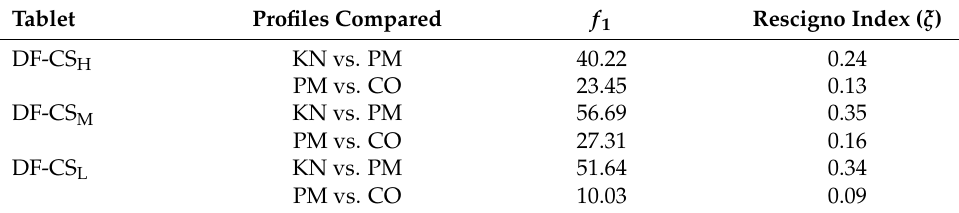
Table 1. Comparative parameters for diflunisal release